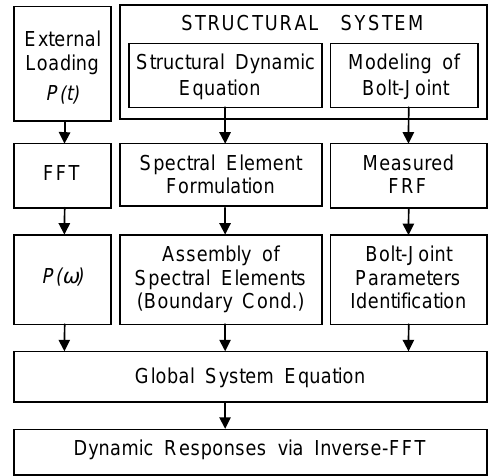
Fig. 5. Spectral element analysis procedure for the beam structure with a bolt-joint.